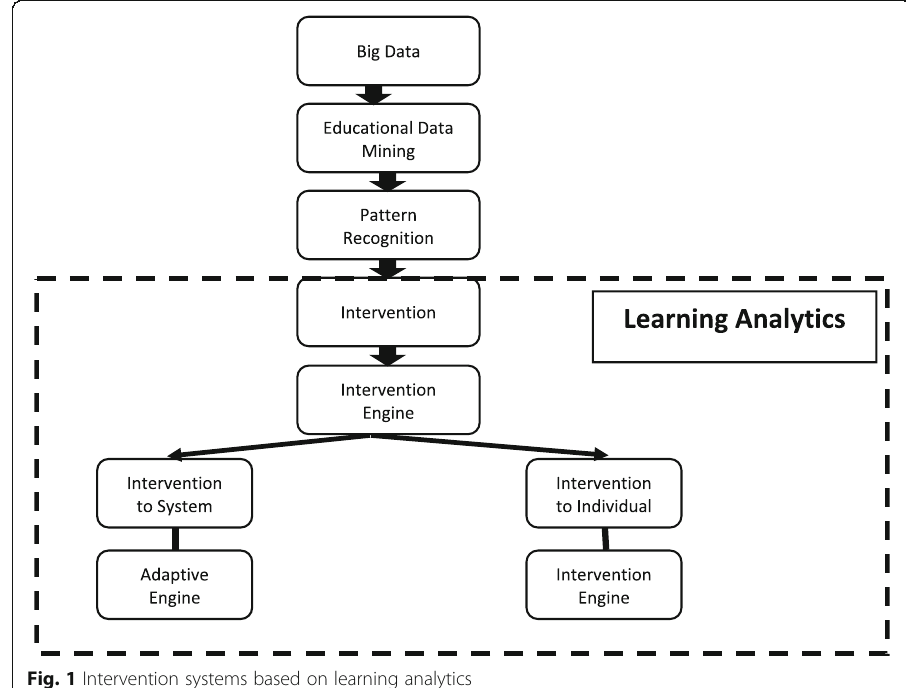
Fig. 1 Intervention systems based on learning